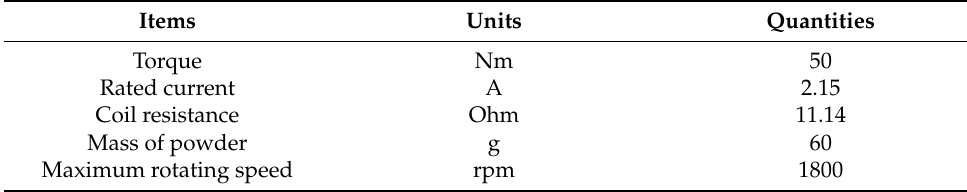
( b ) Figure 8. Experimental results of finding the lowest stator current: ( a ) at 500 rpm with 4.75 Nm; ( b ) at 2000 rpm with 9.5 Nm.